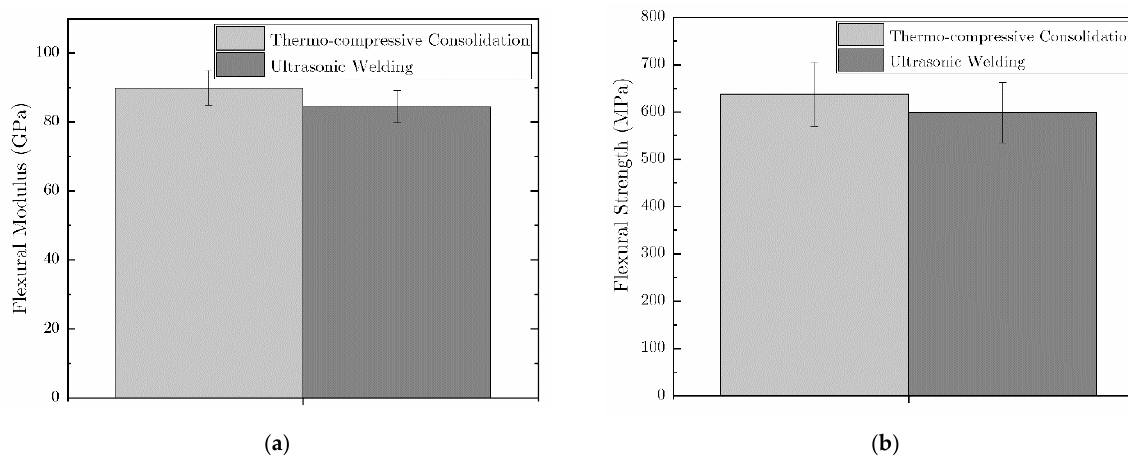
Figure 15. Comparison plots of ( a ) flexural modulus (GPa) and ( b ) flexural strength (MPa), measured for CFRP specimens prepared via thermo-compressive consolidation and ultrasonic welding.